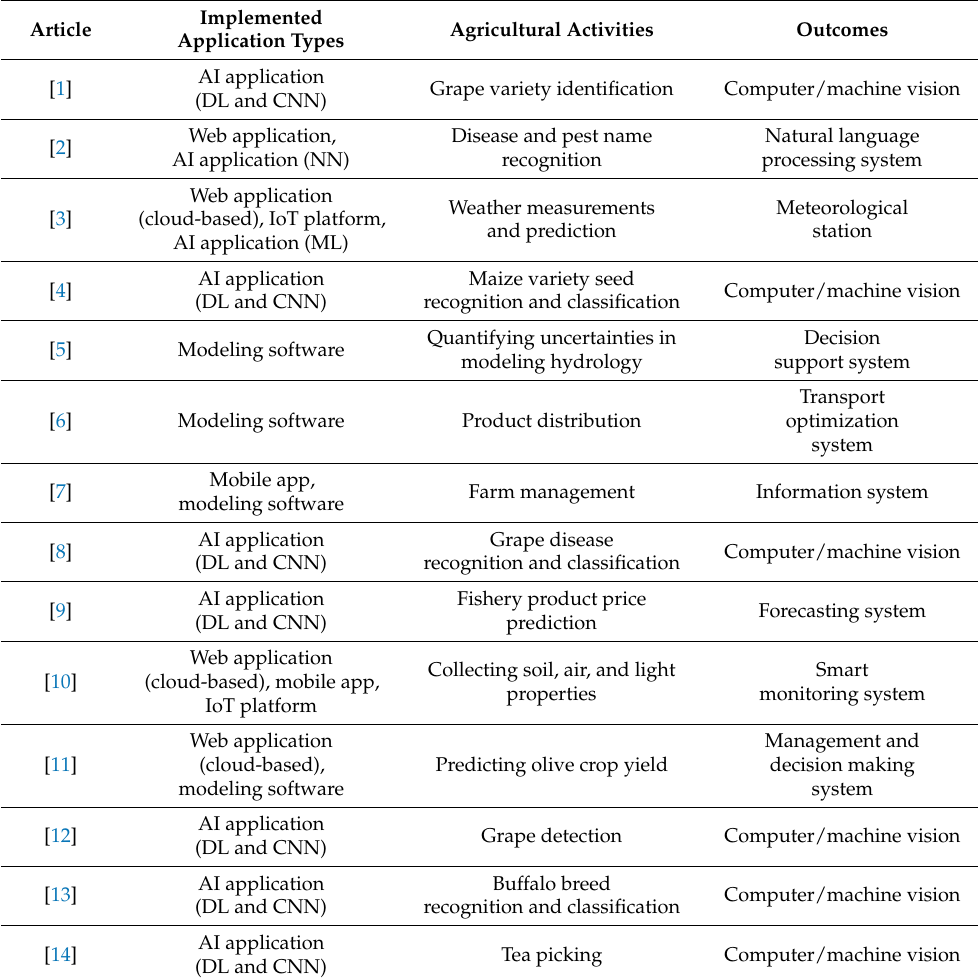
Table 1. Summary of presented